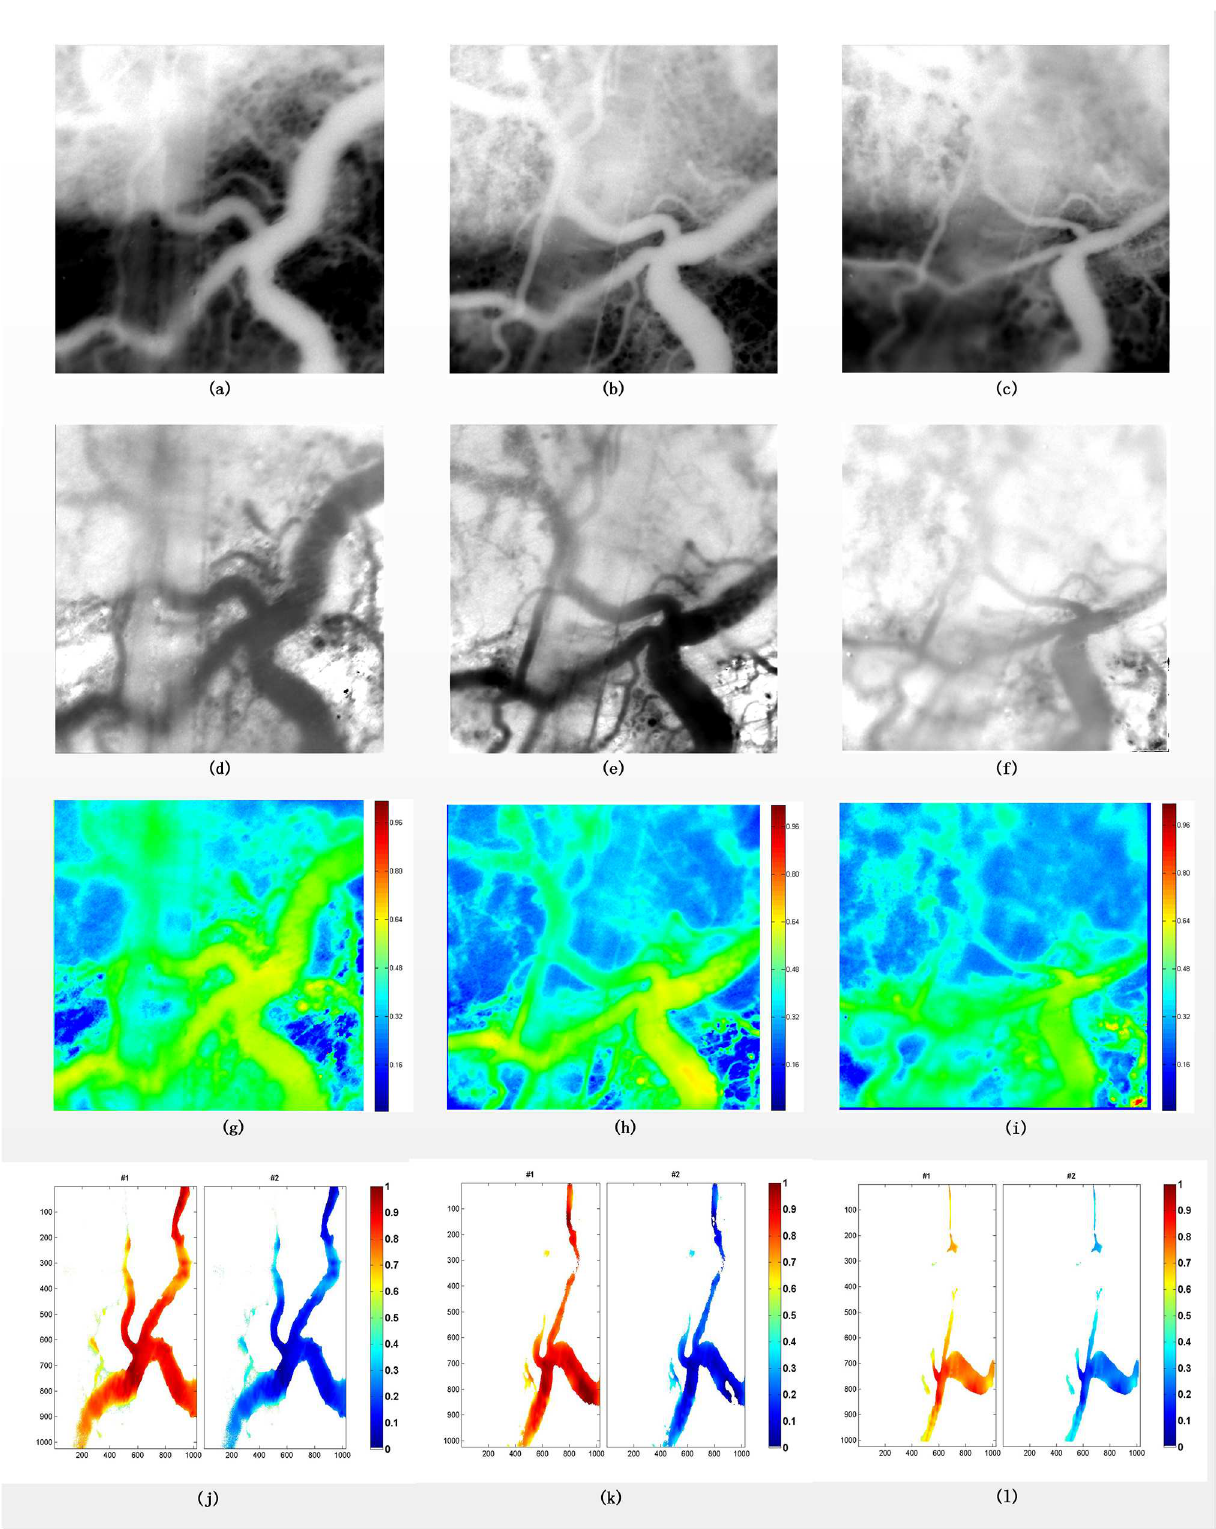
Fig 7. (a) the 12th bandof hyperspectral image in the day 2, (b) the 12th band of hyperspectral image in the day 4, (c) the 12th band of hyperspectral image in the day 6, (d) the ratio image between12th and 30th bandin the day 2, (e) the ratio image between12th and 30th